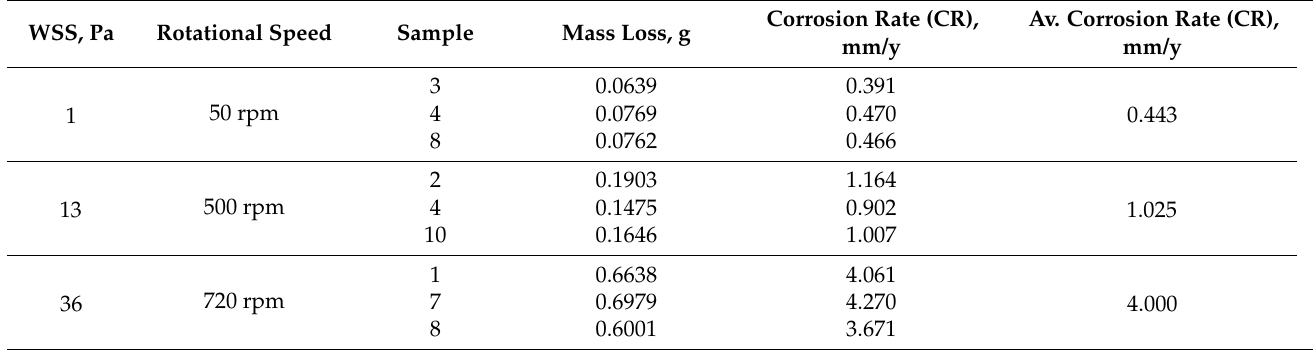
Table 5. Modified RCA method autoclave test